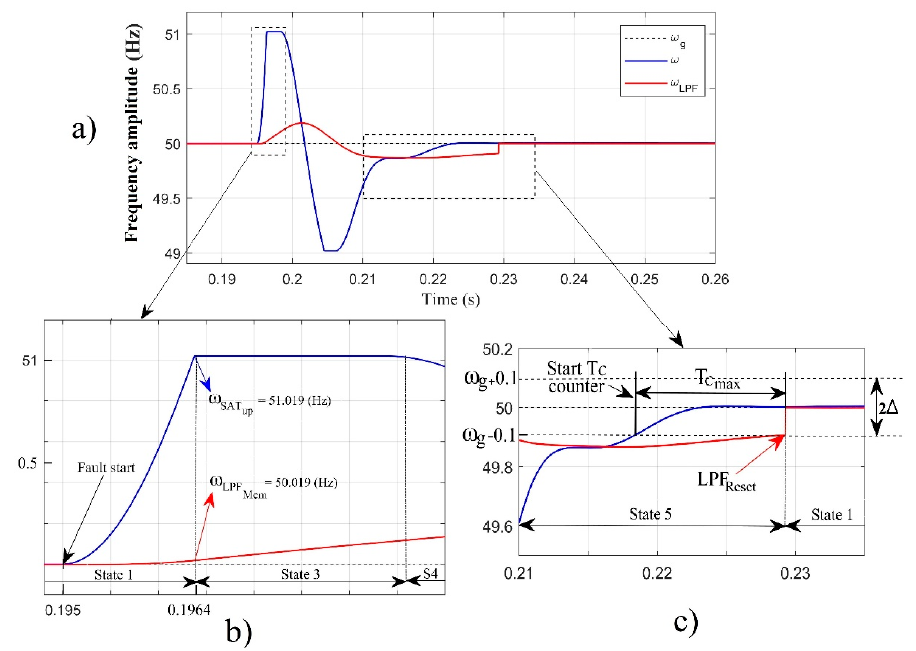
Figure 13. Estimated grid frequency ω and its average value ω LPF transient responses to an 80% depth voltage sag happening at t = 0.195 s. ( a ) ω and ω LPF transient responses. ( b , c ) Transient details.